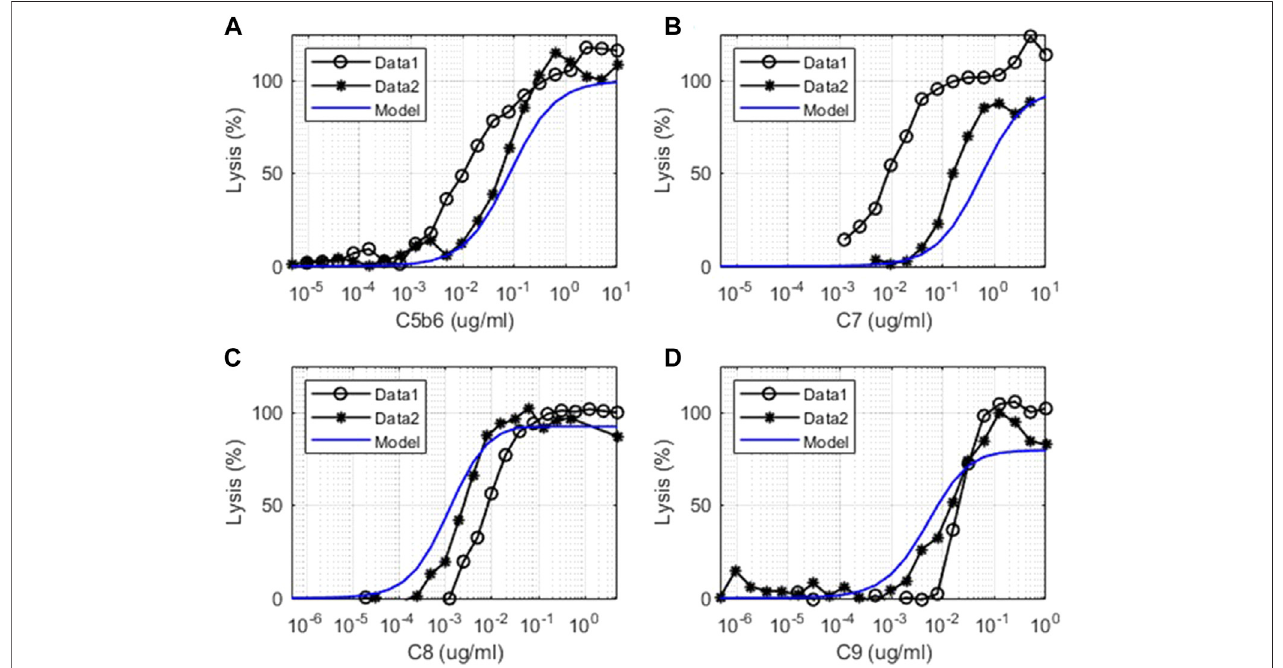
FIGURE6| Comparisonofmodelsimulationswith invitro assaydataforterminalpathways.Modelsimulationresultsaredenotedbysolidblueline,andtheterminal pathway assay resultsare from twosets ofindependent, identical experiments denoted as “ Data1 ” (o) and “ Data2 ” (*). Dose – responseofcelllysis isshown for different